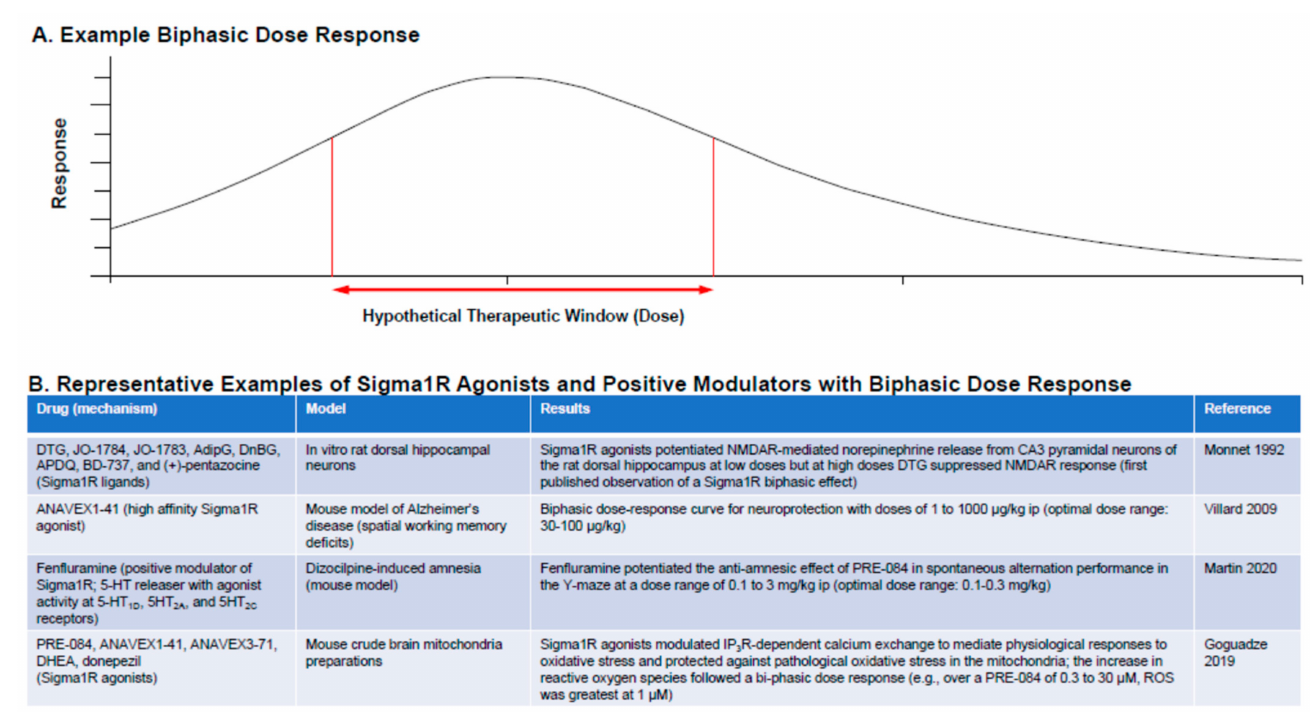
Figure 4. Biphasic dose response is a characteristic of many Sigma1R ligands. ( A ) Example dose–response curve showing therapeutic window for a response. ( B ) Representative examples of Sigma1R agonists and positive modulators following biphasic dose response